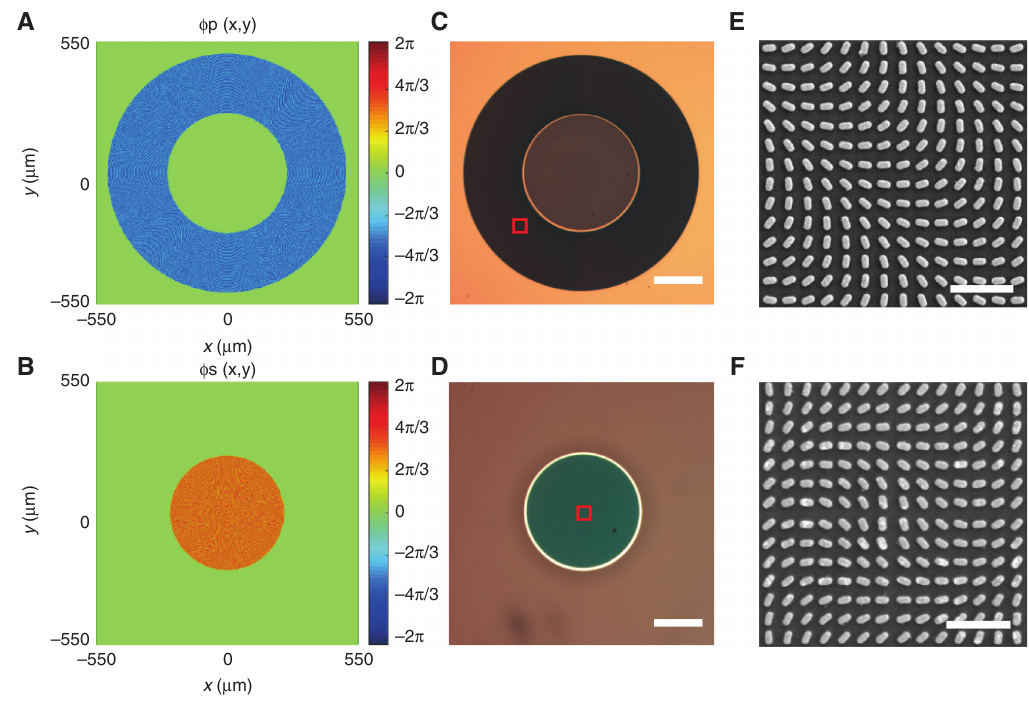
Figure 2: Design and fabrication of the Cassegrain metasurface telescope with F = 6.25 at a wavelength of 780 nm. (A, B) The phase profiles of the primary and secondary metamirrors (PM and SM) with geometric parameters: R = 500 μ m, h = 800 μ m. (C, D) The optical images of the fabricated PM and SM, respectively (scale bar: 200 μ m). (E, F) SEM images of the R 3 PM and SM over the regions marked by red boxes in (C) and (D), respectively (scale bar: 1 μ